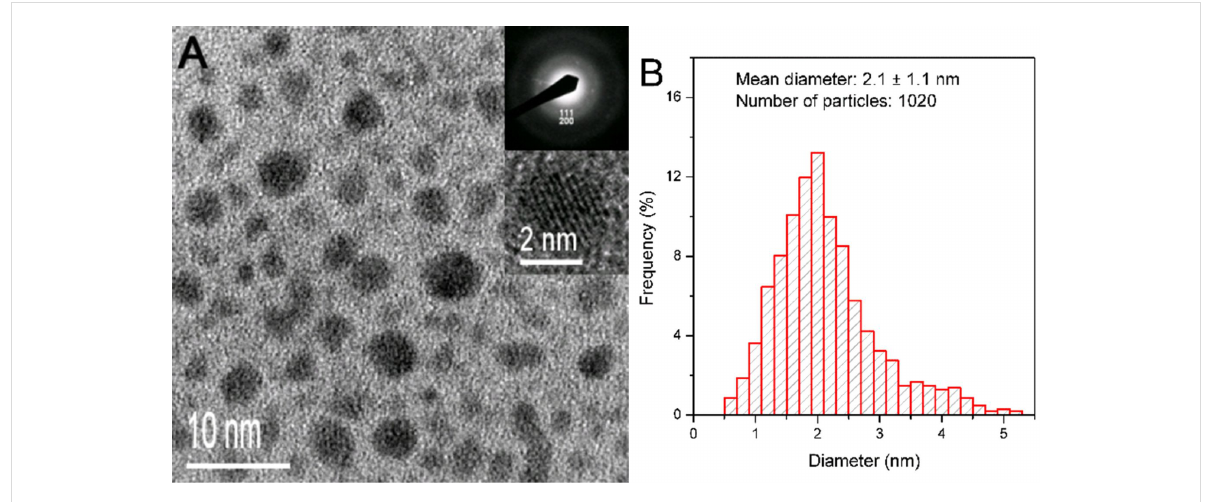
Figure 2: (A) HRTEM image of the crude penicillamin–AuNC product. The upper and lower insets display the SAED pattern and lattice fringe image of the AuNCs, respectively. (B) Size histogram of the crude penicillamine-protected AuNC product.